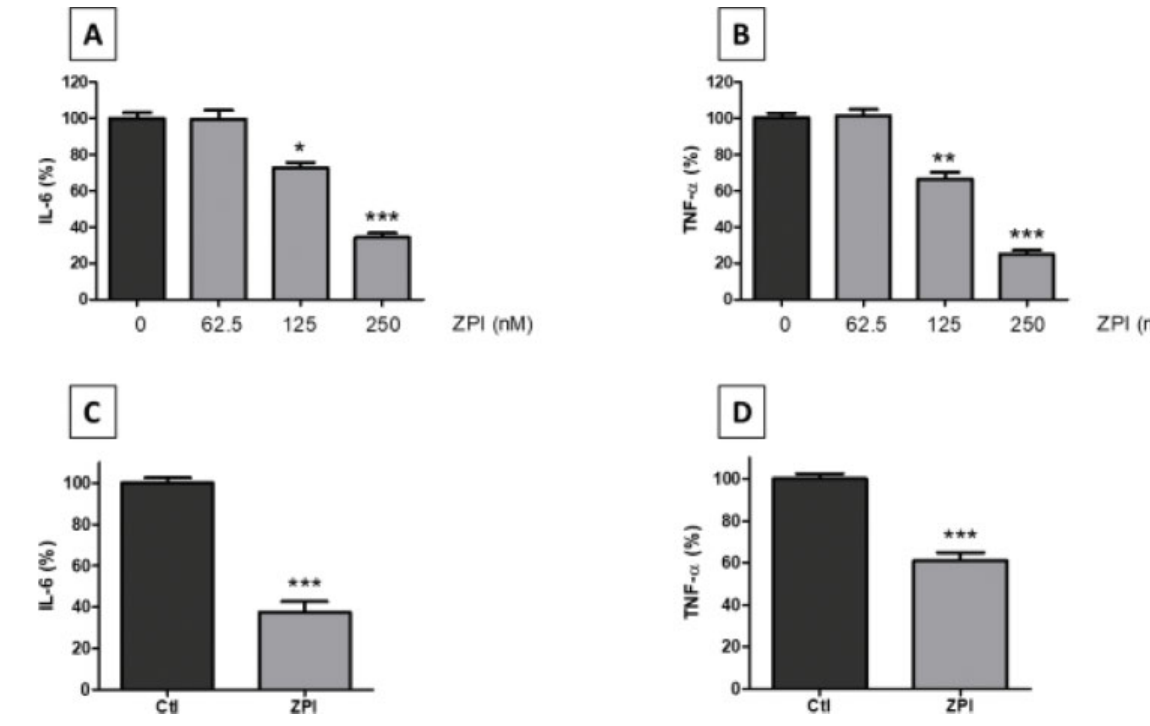
Fig. 3 Effects of recombinant human ZPI (rhZPI) on the secretion of IL-6 and TNF- α in whole blood activated by lipopolysaccharide (LPS). Cytokineswere quanti fi edafter a 20-hour ( A, B ) or 4-hour ( C, D ) incubation. In the latter case, rhZPI wasaddedat 250 nM. rhZPI was added 30 min before the addition of LPS (10 ng/mL). Results are expressed as percentages of IL-6 or TNF- α production in the absence of rhZPI (controls) which were considered arbitrarily as 100%. Results (mean (cid:4) 1 SEM) are the average of 3 ( A, B ) or 4 ( C, D ) independent experiments in triplicate. (cid:5) p < 0.05, (cid:5)(cid:5) p < 0.01, (cid:5)(cid:5)(cid:5) p < 0.001 as compared to the production of cytokines in the presence of LPS alone [Dunnett ’ s multiple comparisons test following one-way ANOVA ( A, B ) or Student ’ s t -test ( C, D